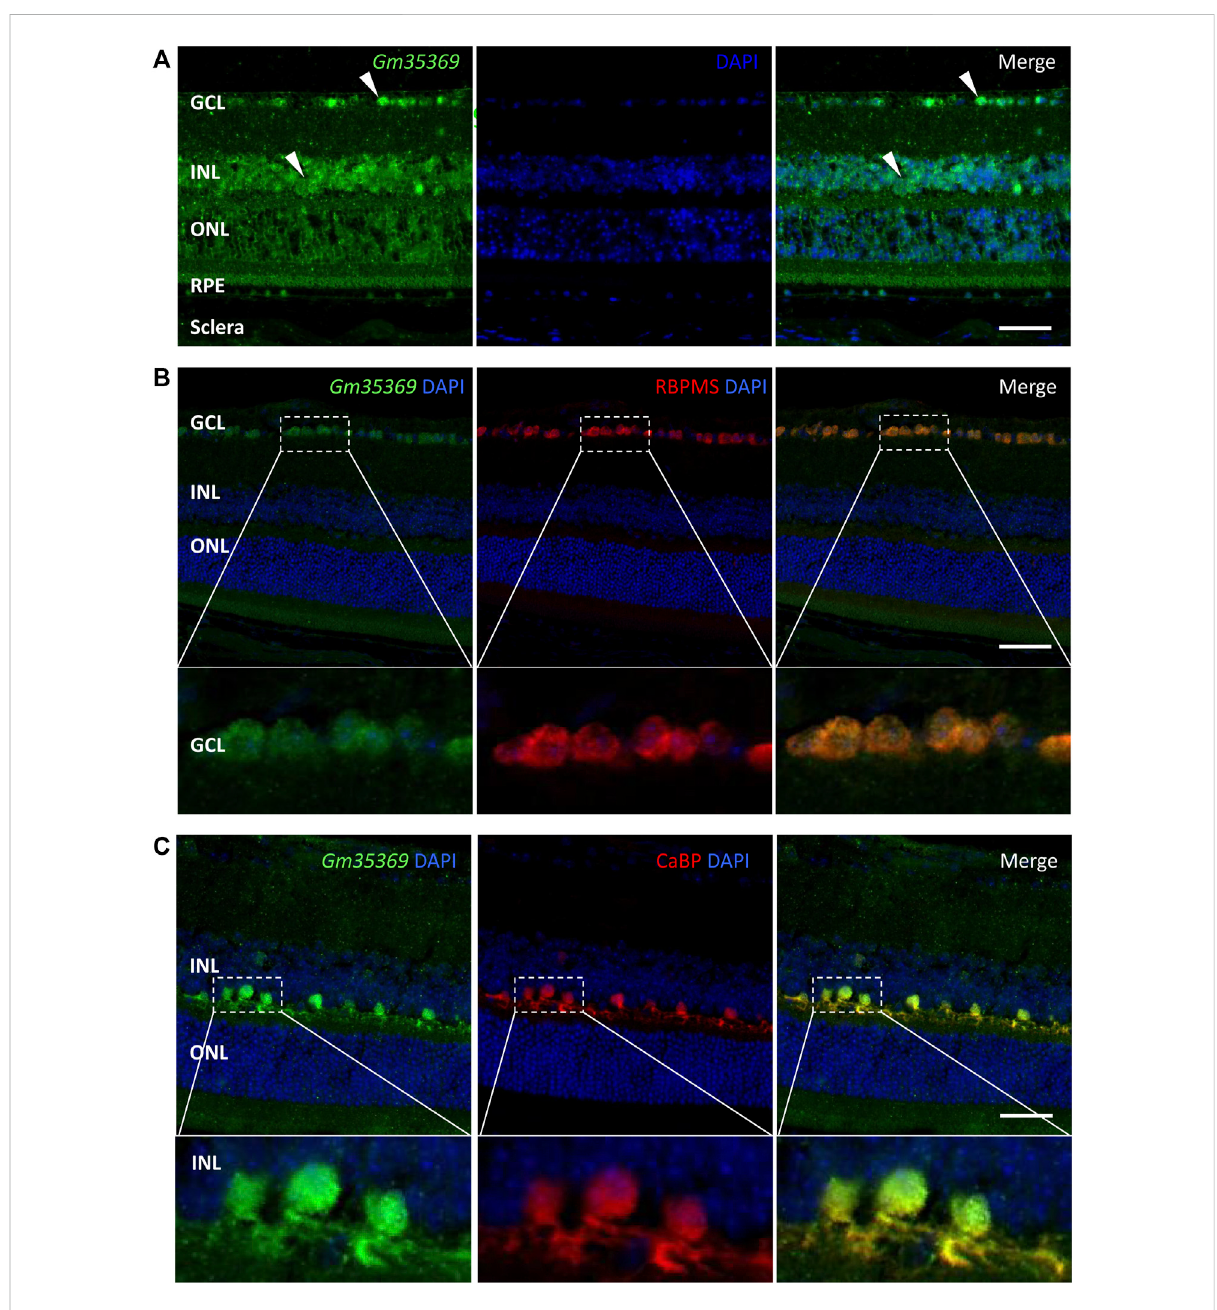
GCL. (C) Colocalization of the horizontal cell markers CaBP ( red ) and Gm35369 ( green ). Signals were apparent in both the nucleus and cytoplasm. DAPI ( blue